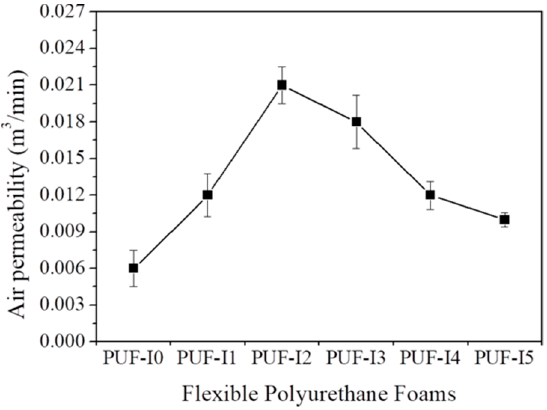
Figure 2. Air permeability of the various FPUFs studied.